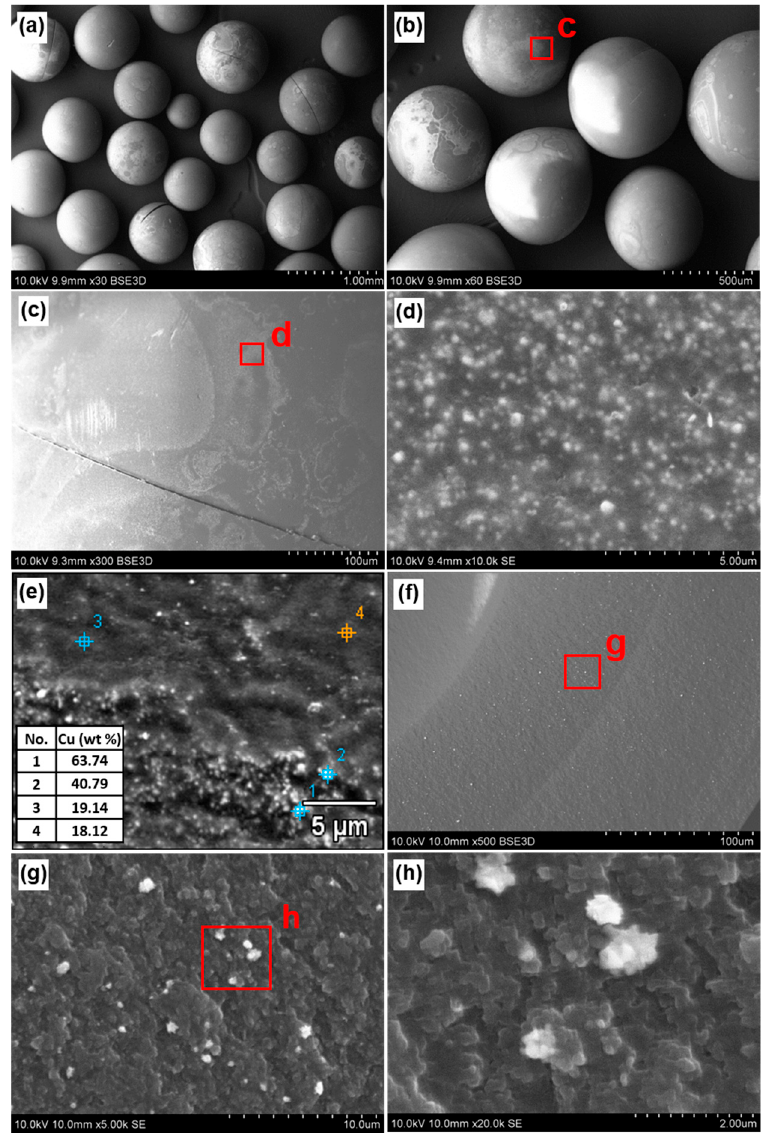
Figure 10. SEM images and EDS analysis of the M/An/Cu-2/FD ( a )–( e ) surface, ( f )–( h ) inside.